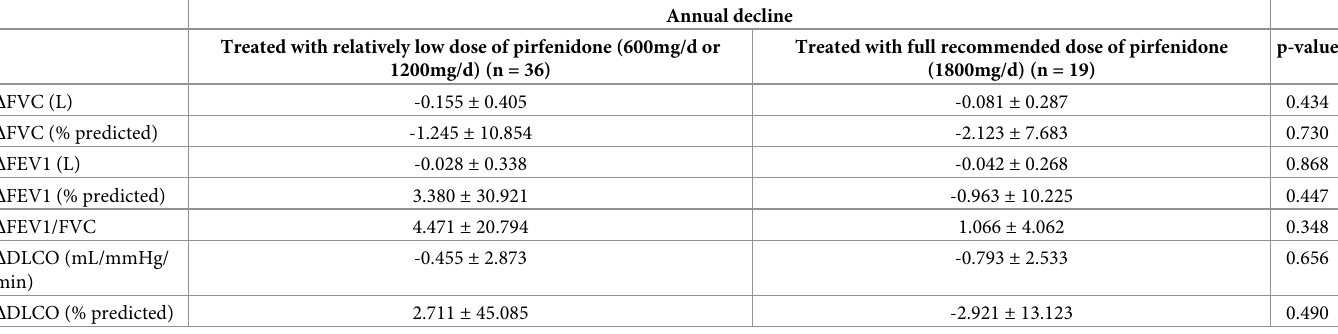
Table 7. Comparison of annual decline in pulmonary function between patients who were treated with full recommended dose of pirfenidone (1800mg/d) and rela- tively low dose of pirfenidone (600mg/d or 1200mg/d).